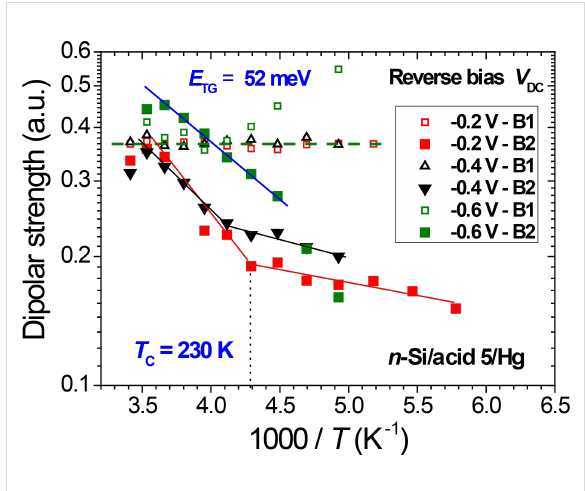
Figure 7: Temperature dependence of the dipolar relaxation strength Δε of peaks B1 and B2, measured at reverse bias values V DC = − 0.2, − 0.4, and − 0.6 V. At low applied bias, two different regimes appear, below and above 230 K.